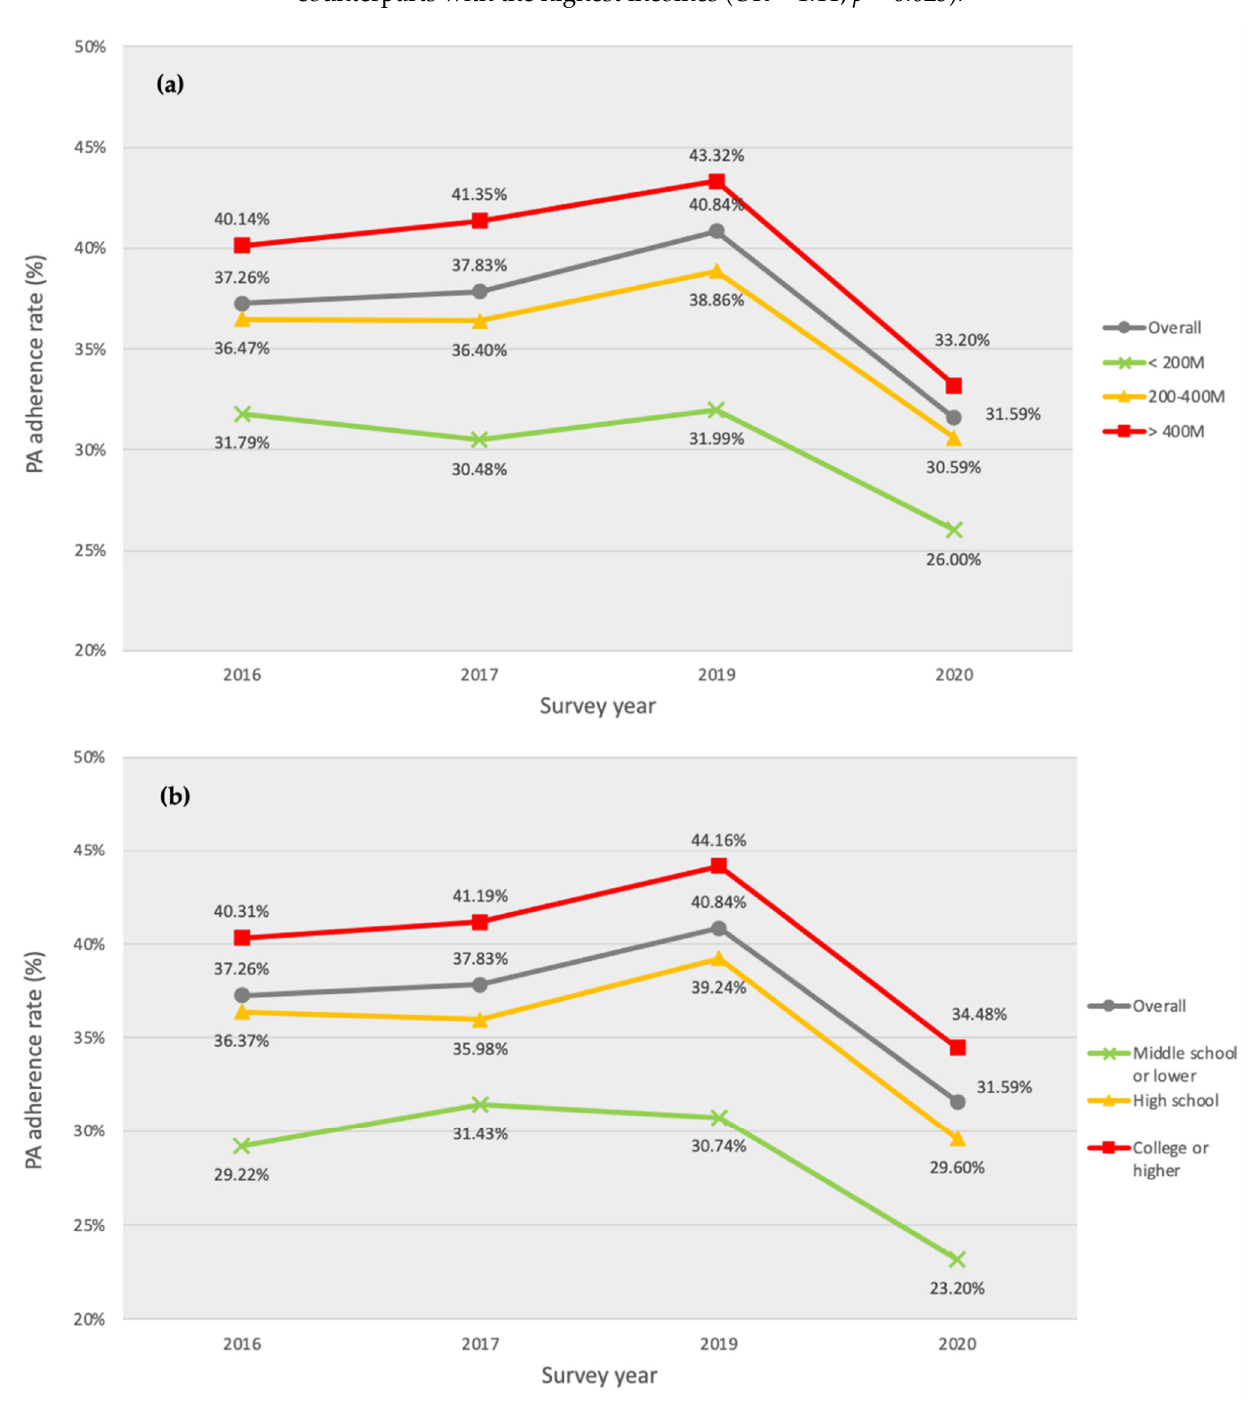
Figure 1. Five-year aerobic physical activity guideline adherence rate trends by socioeconomic status ( a ) household income ( b ) educational attainment (completion of the designated education level).